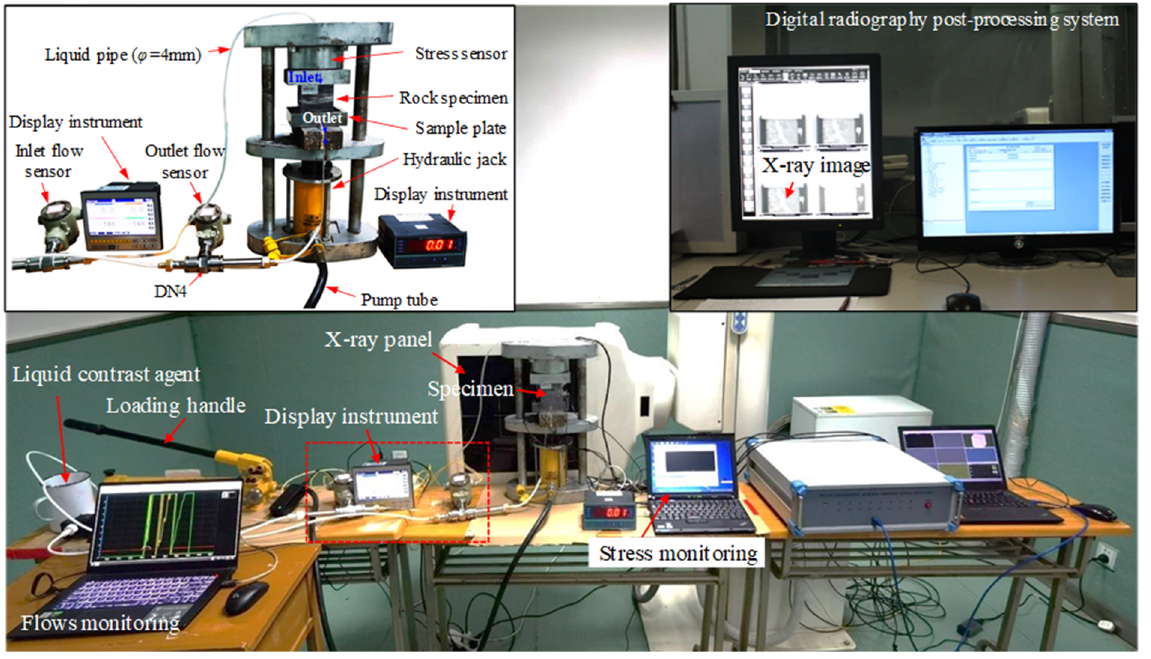
Figure 3. X-ray visualization test platform for fissure flow in red-bed mudstone.